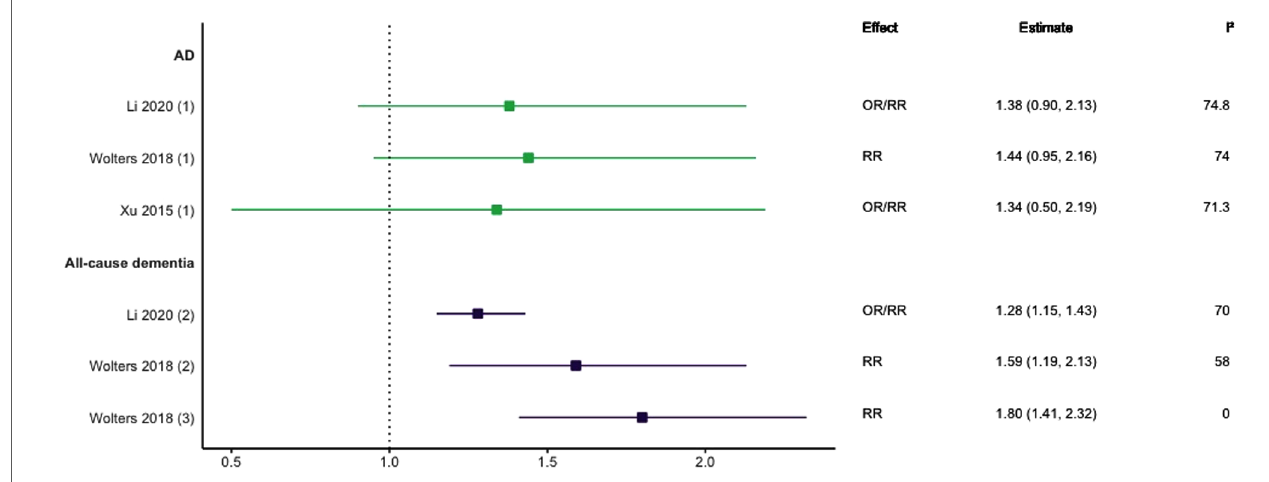
FIGURE 3 Effect estimates of meta-analyses reporting an association between heart failure and dementia, with the vertical line representing no effect. To note, Xu et al. treated ORs as approximates to RRs, as such, violations of this assumption may have implications for the comparability of ORs and RRs, meaning that interpretation of these pooled estimates should be done cautiously. AD, Alzheimer ’ s disease; OR, odds ratio; RR, risk ratio.